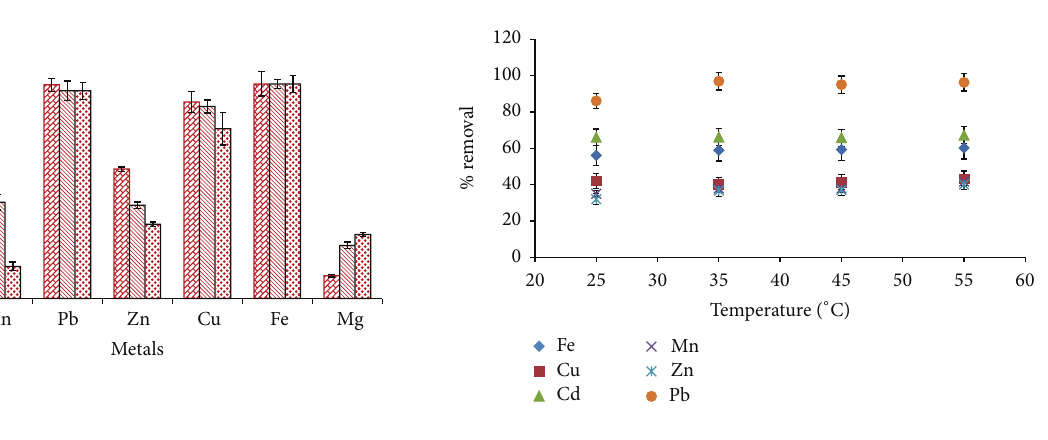
Figure 13: Effect of temperature on metal removal using MSP.